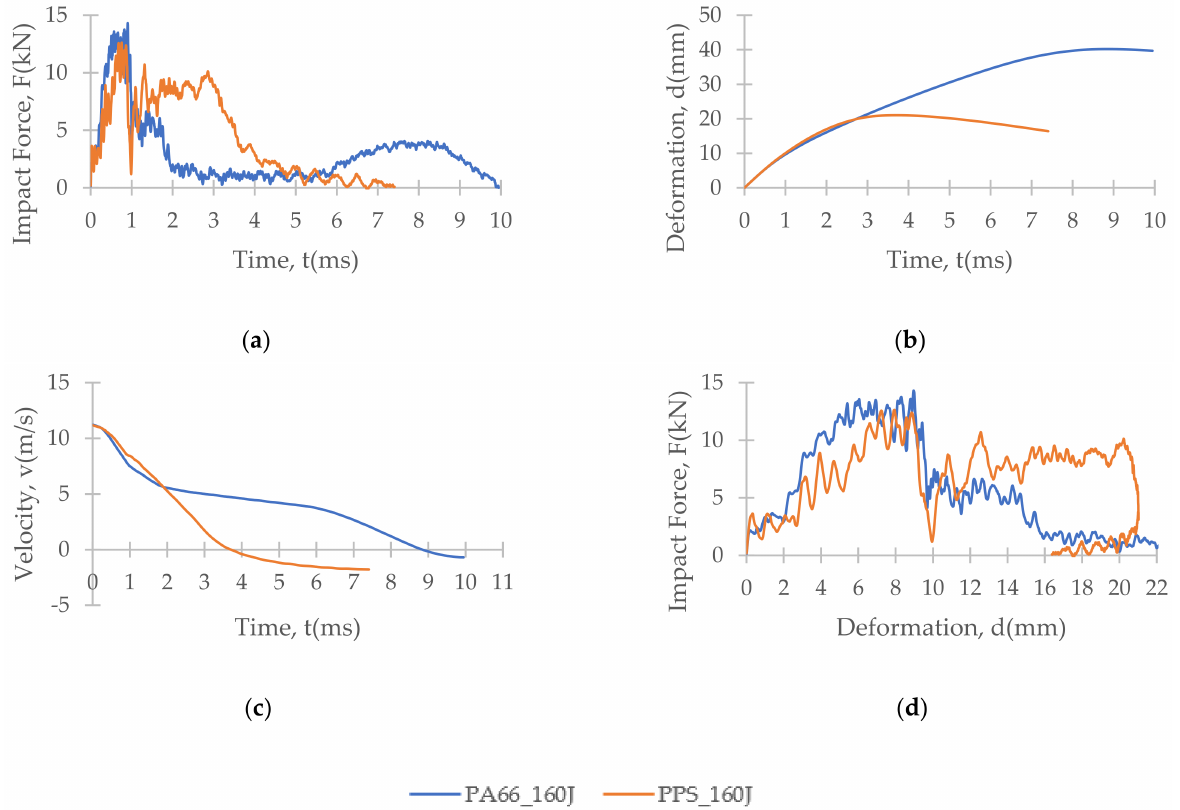
Figure 9. Time histories: ( a ) force-time, ( b ) deformation-time and ( c ) velocity-time; and ( d ) force-displacement plot of T700/PA6.6 and T700/PPS CFRTP composite systems under 160 J impact